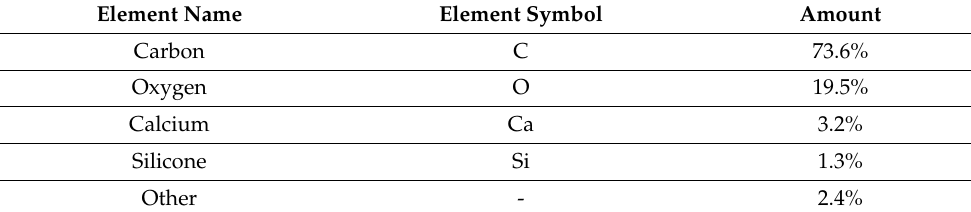
Table 4. Chemical composition of material M4.